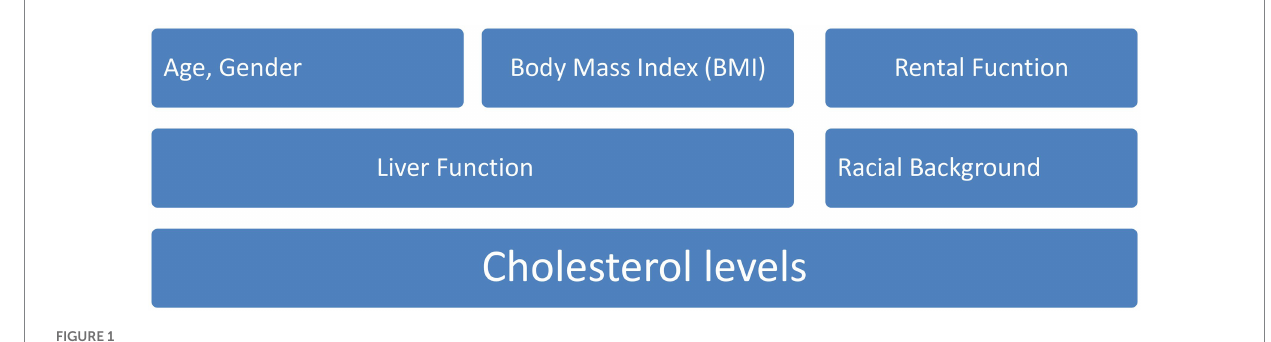
FIGURE 1 Several factor influencing incidence in cardiovascular